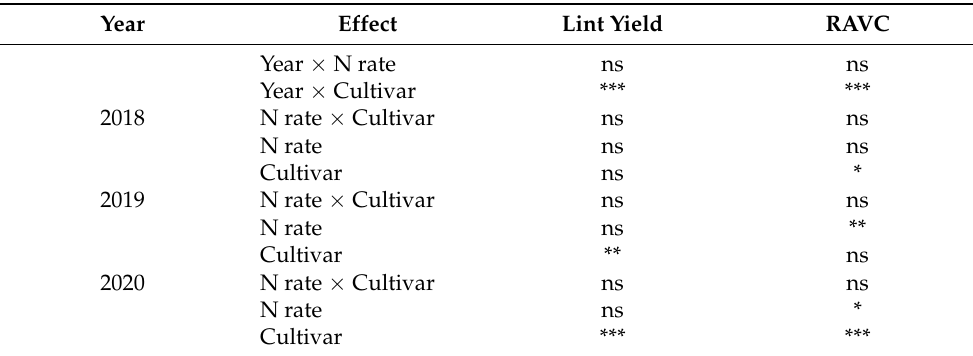
Table 4. Lint yield of cotton cultivars grown under five rates of nitrogen (N) at the Texas Tech University Research Farm, New Deal, TX, USA in 2018–2020.